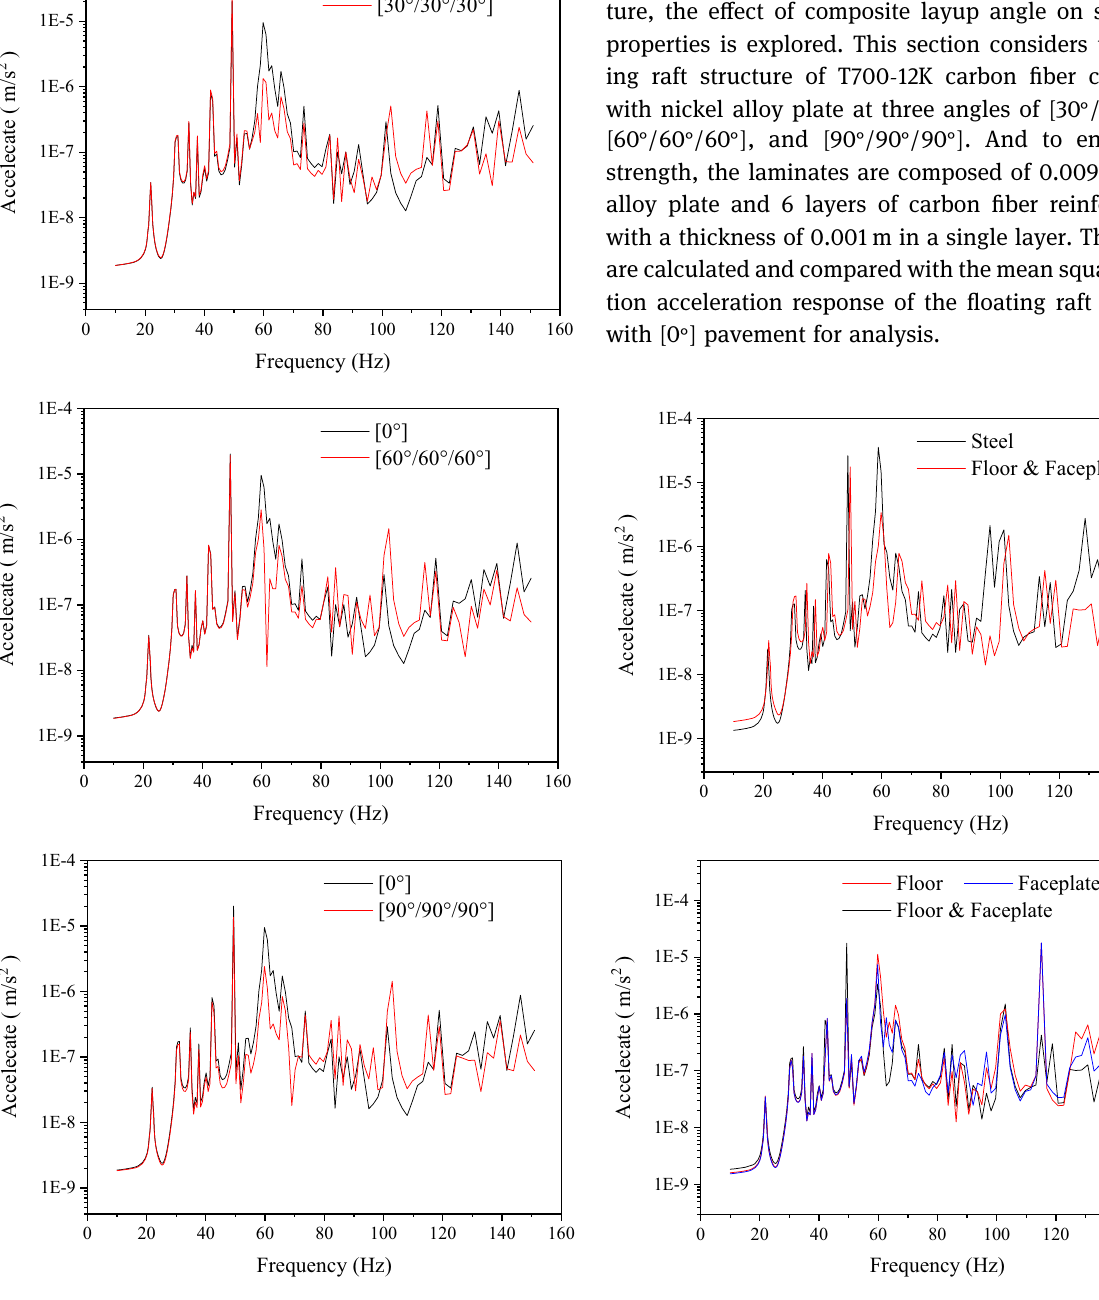
Figure 9: In fl uence of laying position on vibration damping